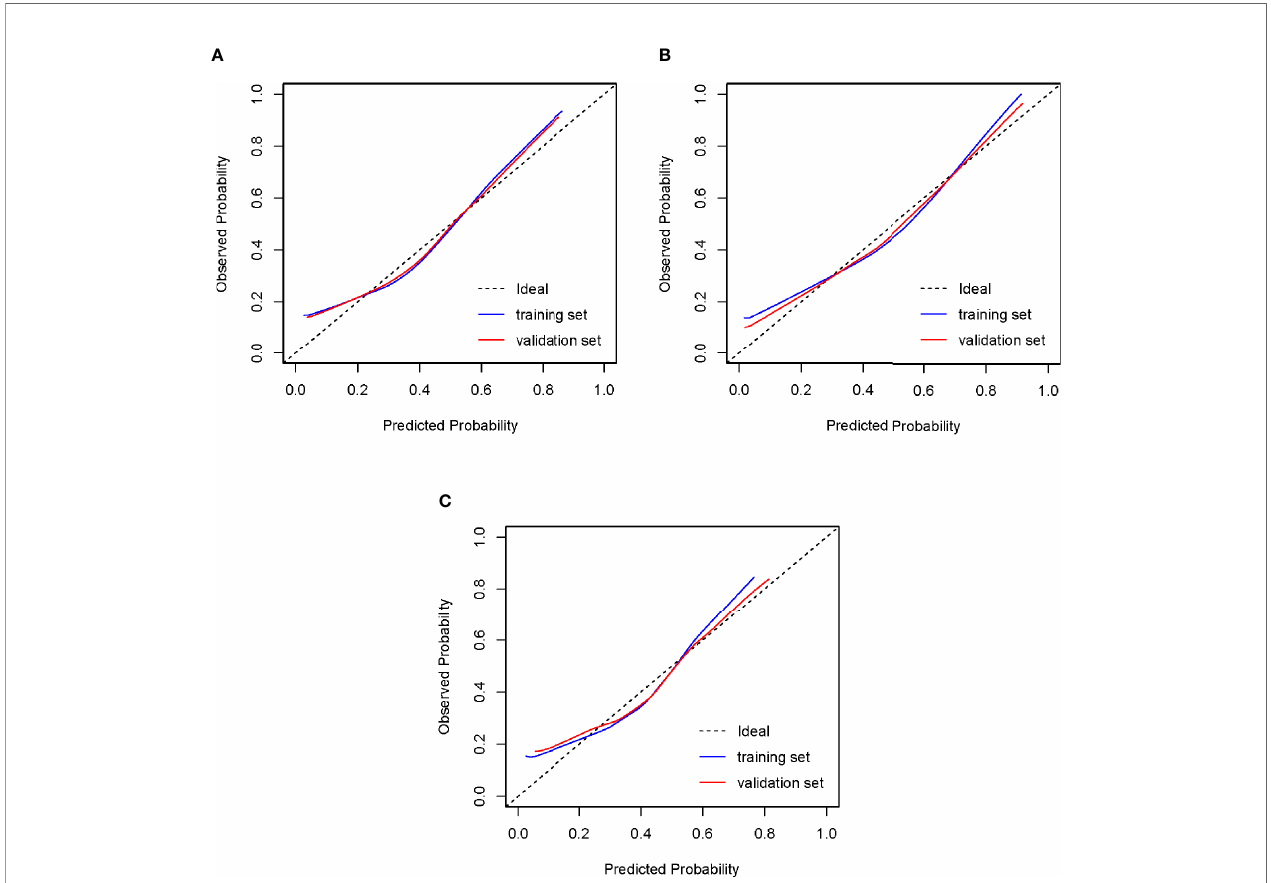
FIGURE 5 | Calibration of the models to predict blastocyst formation in vitro . The diagonal lines in the fi gures represent ideal prediction models. The blue lines and the red lines represent the actual prediction models of the training sets and the validation sets, respectively. The closer their proximity to the diagonal lines, the higher the prediction ef fi ciency of the models. (A) Tubal factor group; (B) PCOS group; (C) endometriosis group. PCOS, polycystic ovary